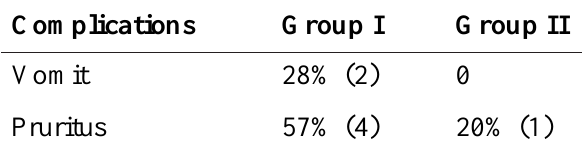
Table 4. Post-operative